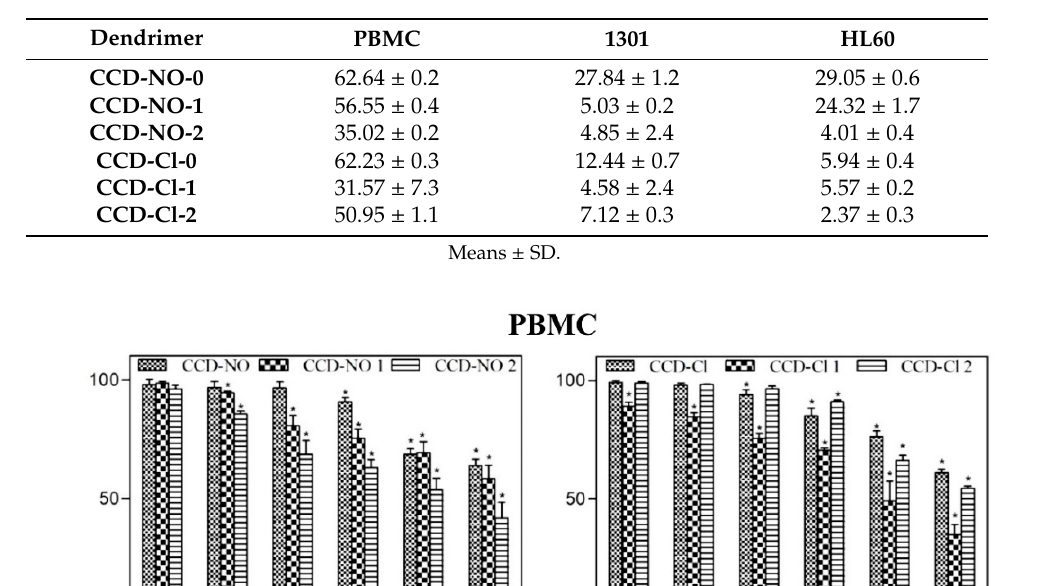
Table 4. IC 50 values of copper metallodendrimers in normal peripheral blood mononuclear cell (PBMC) and cancer: 1301, HL-60 cell lines after 24 h incubation. The values are the mean ± SD of n ≥ 6.